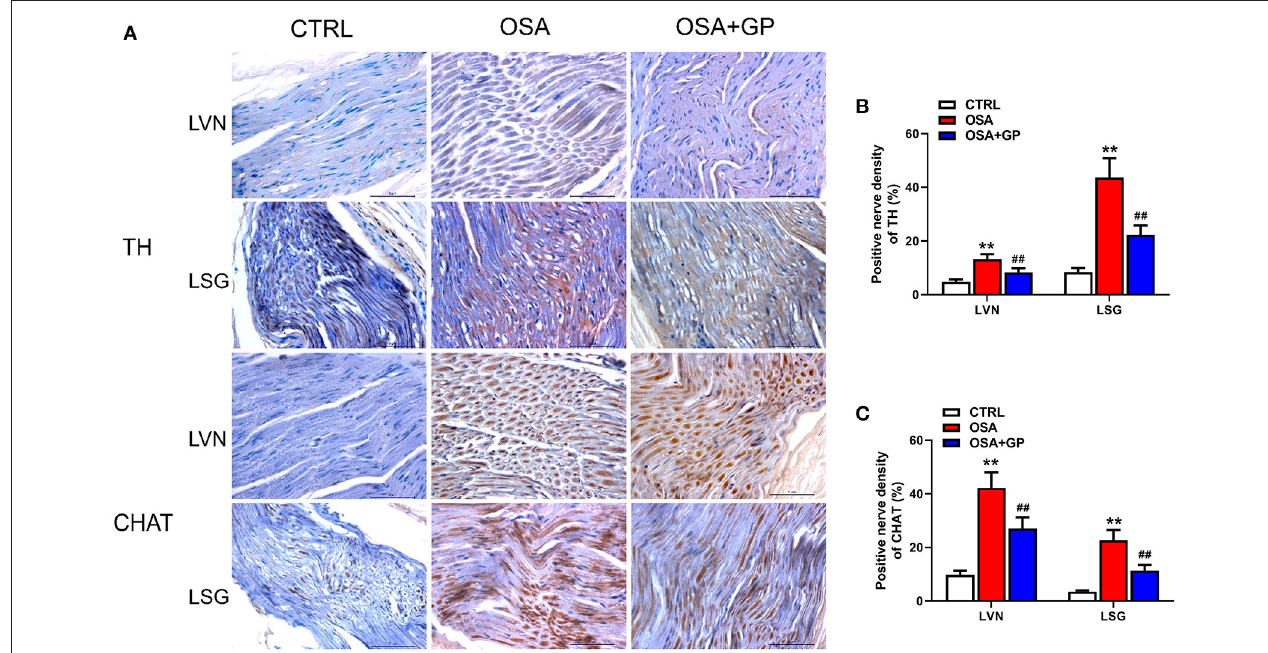
FIGURE 10 | Effect of SLGP ablation on the expression level of TH and CHAT among the three groups. Representative immunohistochemical staining (A) and quantitative analysis of TH (B) and CHAT (C) in LVN and LSG; ** P < 0.01 vs. CTRL, ## P < 0.01 vs. OSA; TH, tyrosine hydroxylase; CHAT, choline acetyltransferase; abbreviations as in Figures 1 , 9